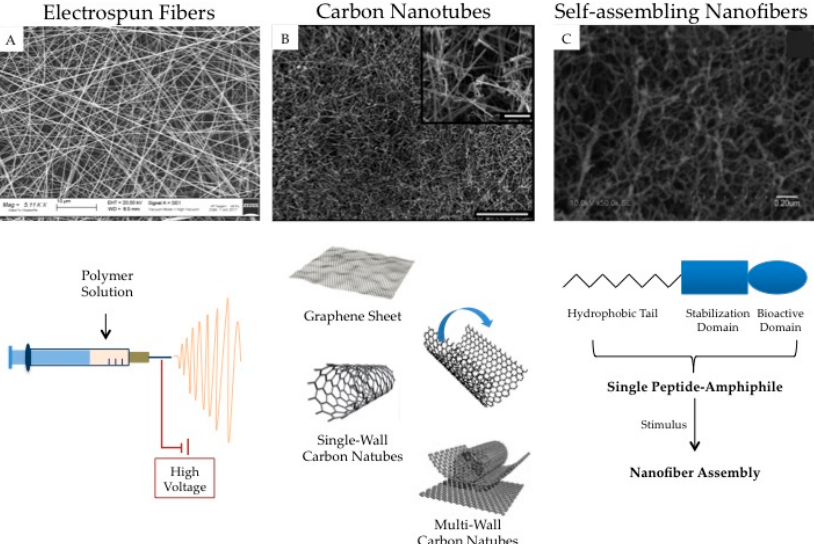
Figure 2. Nanotechnological approaches for the fabrication of fibrillar structures for the treatment of SCI. ( A ) Scanning electron micrograph (Zeiss EVO MA10 (Carl Zeiss, Oberkochen, Germany) shows random dextran/alginate fibers; ( B ) Scanning electron micrograph of carbon nanotubes; scale bars: 250 and 25 µ m (inset) (adapted [138]); ( C ) Scanning electron micrograph of self-assembling nanofibers (adapted from [139]).